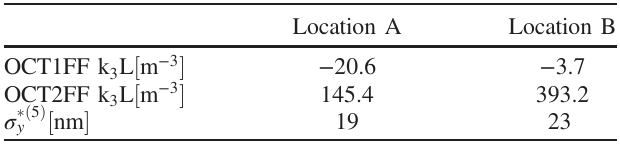
TABLE IV. Integrated strengths of the octupole magnets in locations A and B and corresponding vertical beam size at IP of 5th order.